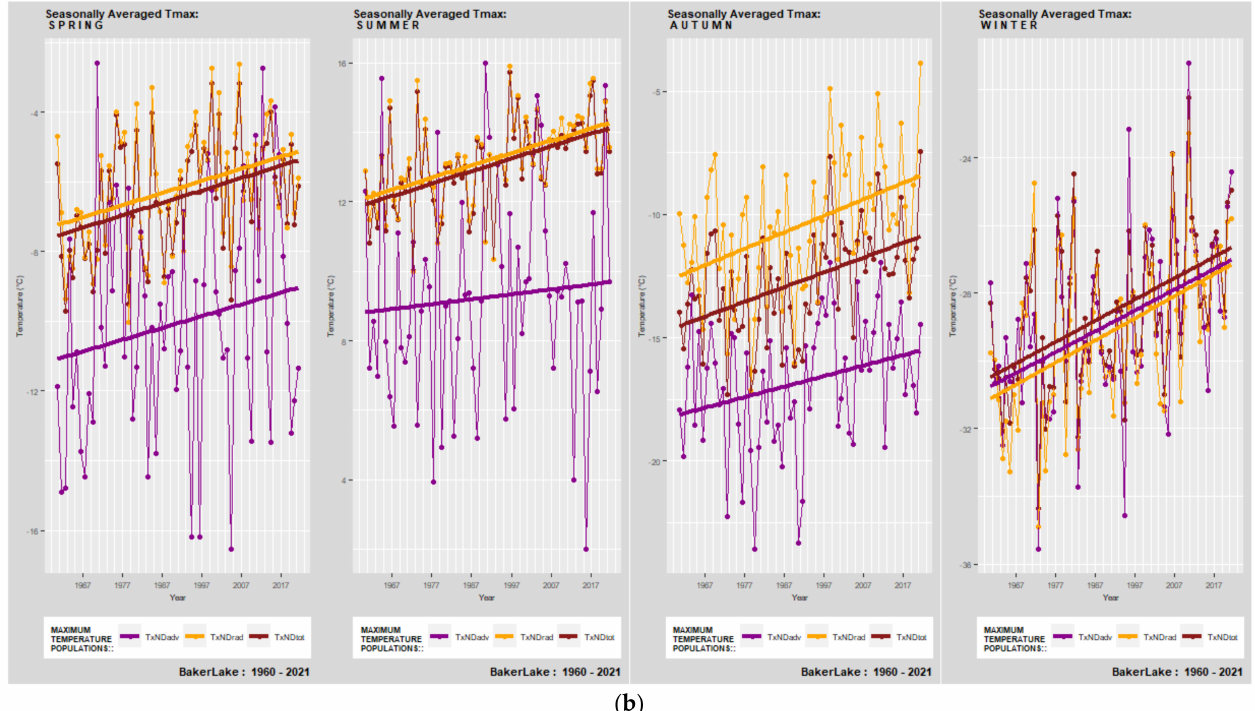
Figure 13. Arctic Tundra (ART); Baker Lake (NU). Seasonally averaged daily temperature minima ( a ) and maxima ( b ), listed in order of Spring, Summer, Autumn, and Winter. ( a )—Total Temperature Minimum ( TT n ) (green), Radiative Temperature Minimum ( RT n ) (blue), and Advective Temperature Minimum ( TT n ) (pink); ( b )—Total Temperature Maximum ( TT x ) (brown), Radiative Temperature Maximum ( RT x ) (orange), and Advective Temperature Maximum ( TT x )